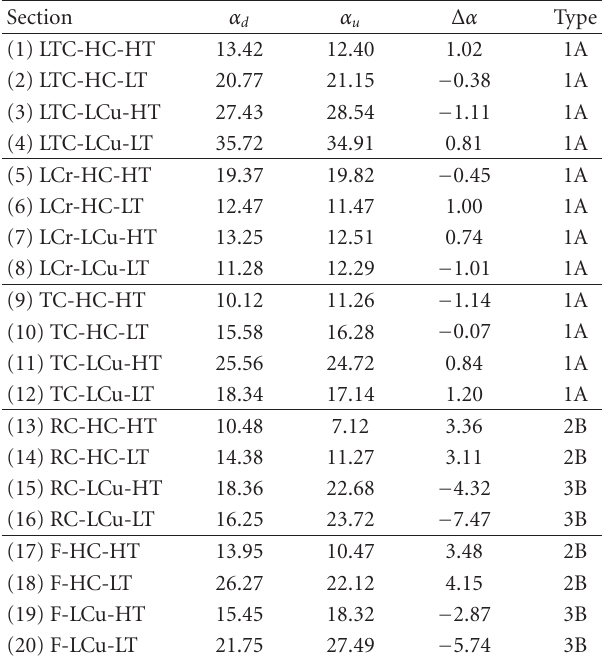
Table 1: Values of α d , α u , and Δ α